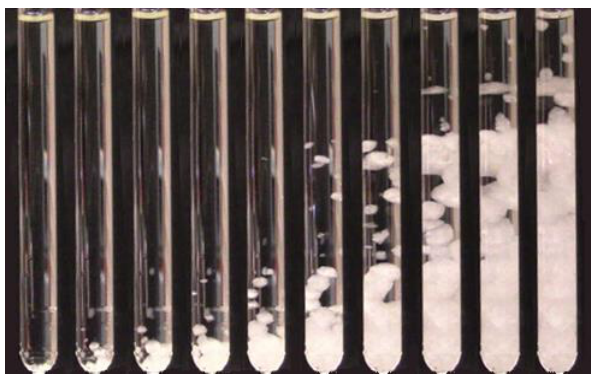
Figure 6. Time-lapse video images (15 s intervals) of a crystallization reaction in 5 mm Pyrex NMR tubes. The temperature gradient across the sample results in T iso = 241 K at the base and 253 K at the top of the sample.